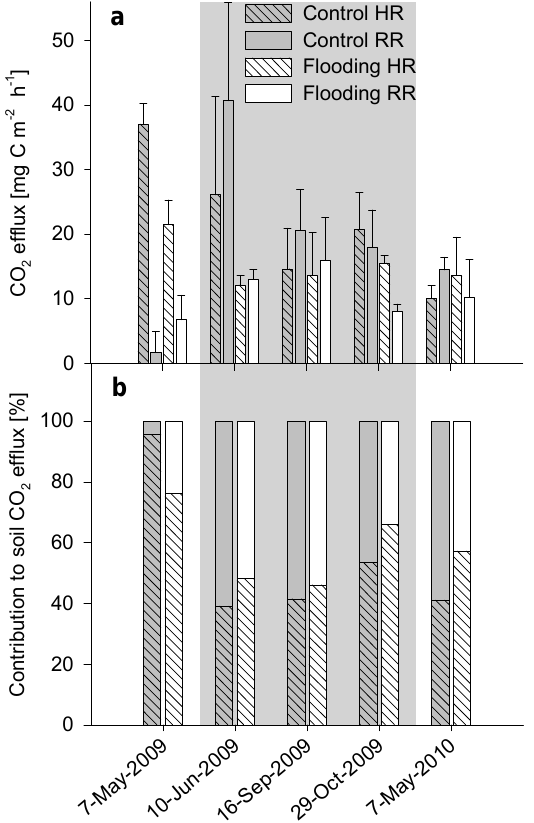
Fig. 5. (a) Soil CO 2 effluxes (mean ± SE) originating from het- erotrophic (HR) and rhizosphere respiration (RR), and (b) their rel- ative contributions to soil CO 2 effluxes in the control and flooded Fig. 5. ( a ) Soil CO 2 effluxes (mean ± SE) originating from heterotrophic (HR) and rhizosphere respiration (RR), and ( b ) their relative contributions to soil CO 2 effluxes in the control and flooded plots.